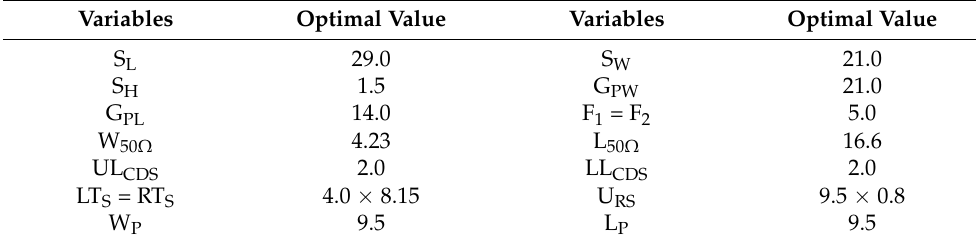
Table 1. Parameters of the proposed antenna (unit: